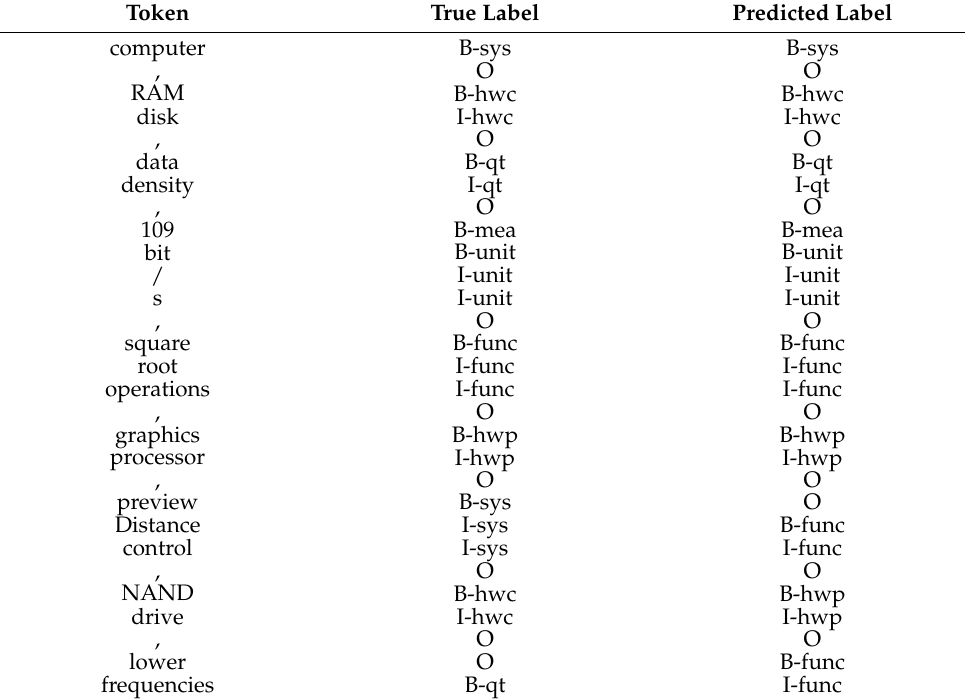
Table 6. Prediction report on test